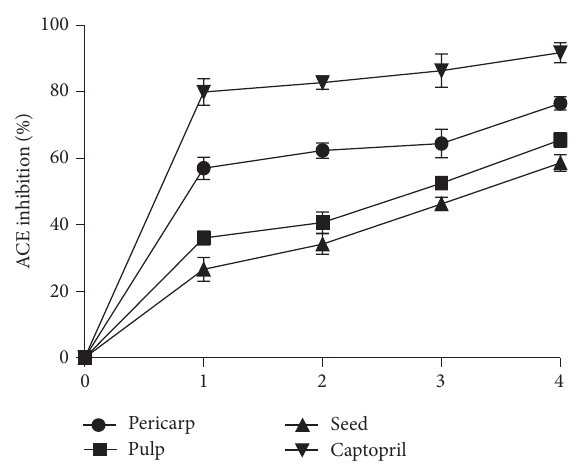
Figure 2: Percentage of 𝛼 -glucosidase inhibition by extracts from Soursop fruit part and acarbose. The concentrations of the extract used for the plot are 0.00, 0.20, 0.40, 0.6, and 0.80 mg/mL. The con- centrations of the acarbose used for the plot are 0.00, 10.00, 30.00, and 40.00 𝜇 g/mL. Values represent mean of standard deviation of triplicate readings.